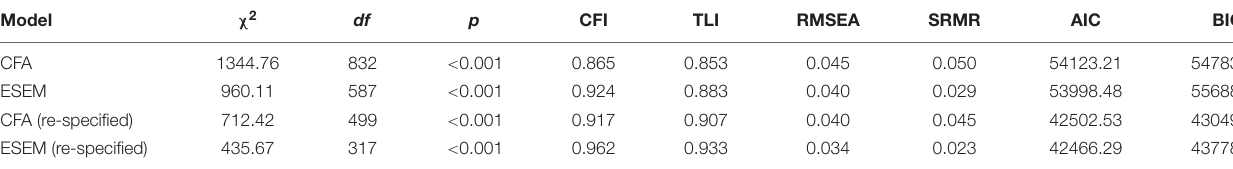
TABLE 2 | Indices of model fit for the life skills scale for sport.